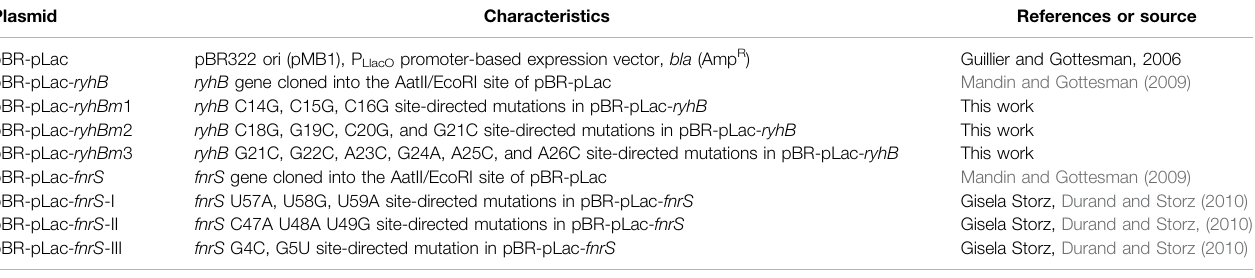
TABLE 2 | Plasmid list. Plasmid